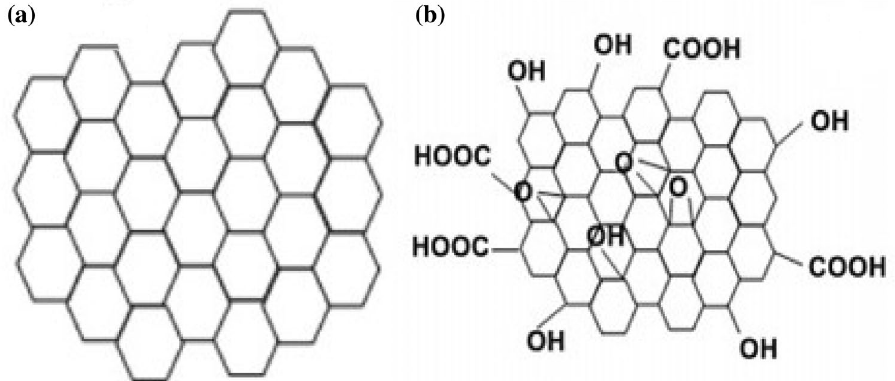
Fig. 11 Structure of a a single graphene sheet and b graphene oxide (GO) (Alam et al.